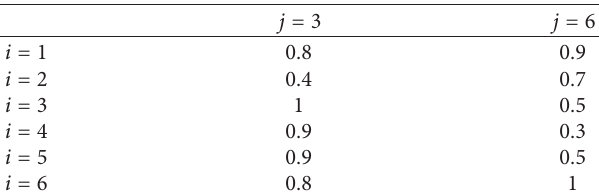
Table 7: Correlation among